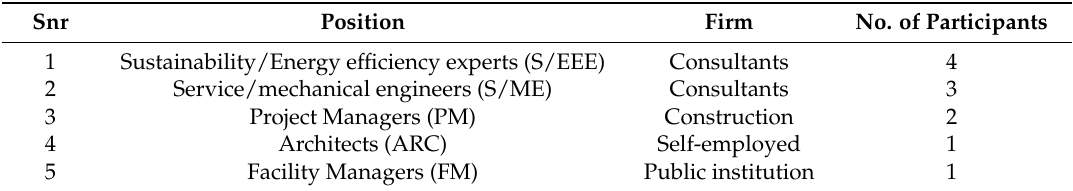
Table 1. Details of